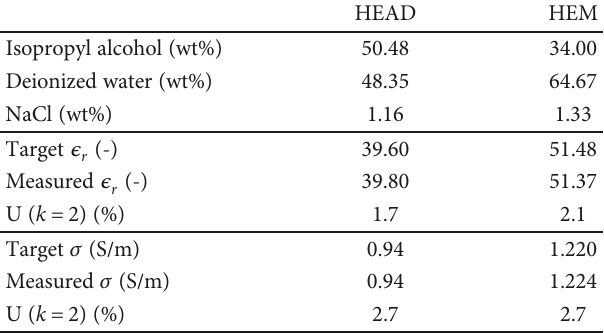
11 Table 1: Phantom composition in weight percent, target, and measured dielectric parameters at 1GHz and 25 ° C, immediately before the measurement in the MWI